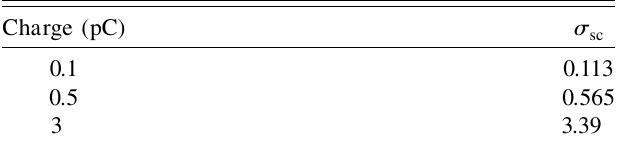
TABLE I. Space charge parameter versus microbunch charge.